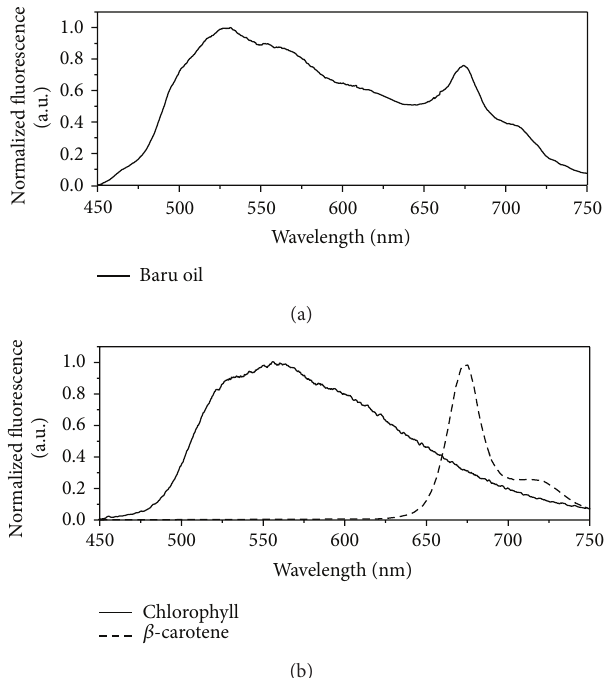
Figure 6: Fluorescence spectrum of (a) Baru oil and (b) 𝛽 -carotene and chlorophyll.